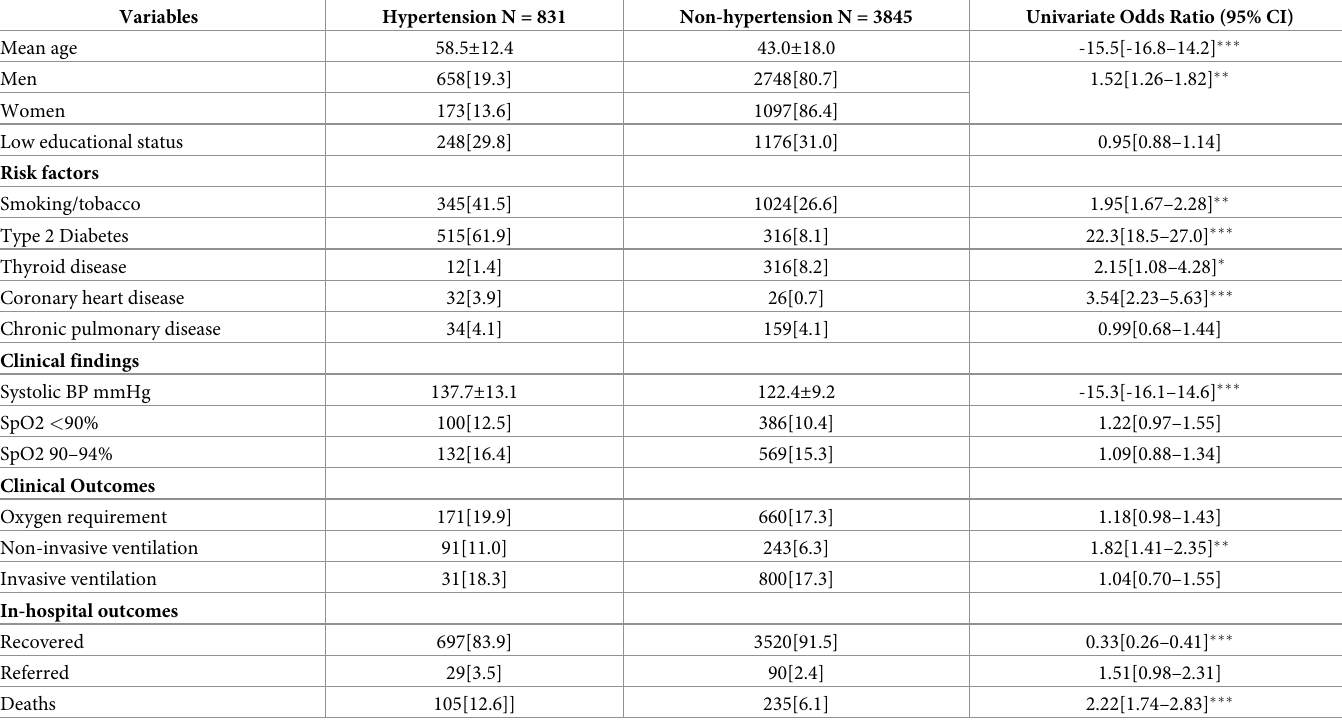
Table 3. Clinical characteristics and outcomes according to